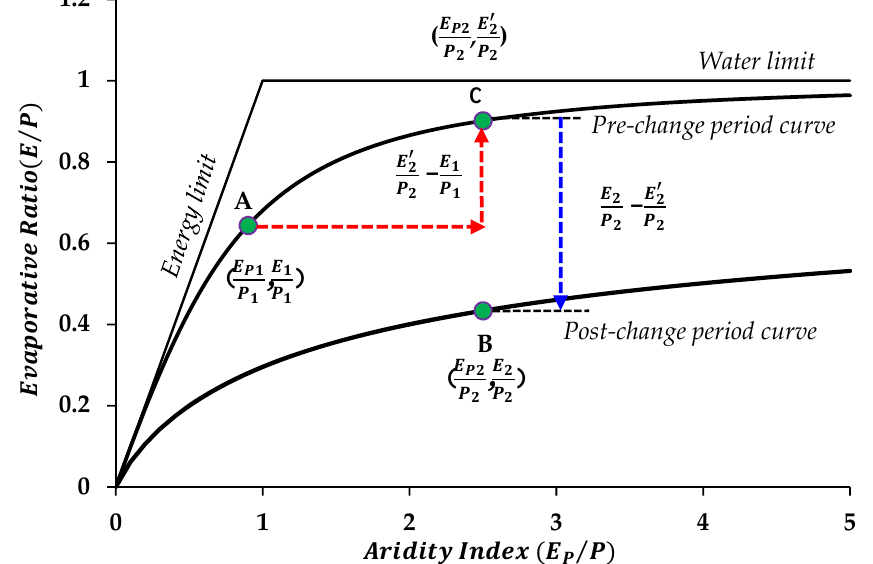
Figure 4. Decomposition method to quantify the climate change and direct human activities impacts on mean annual streamflow.